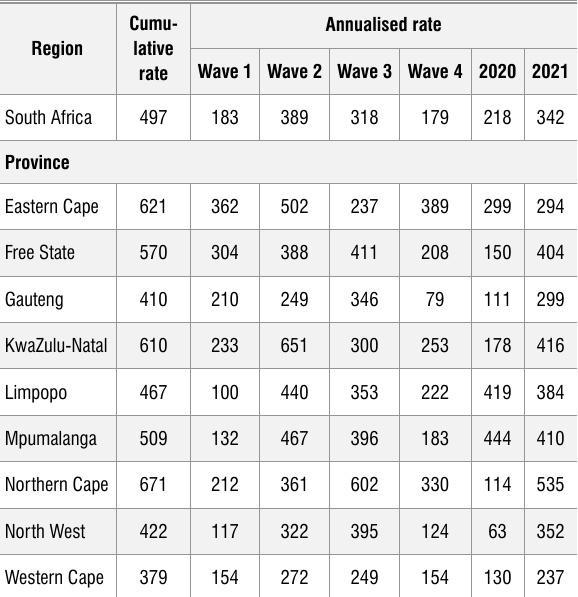
Figure 4: P-score of excess deaths in South Africa by week and age group, 29 December 2019 – 5 February 2022. Figure 5 shows age-specific annualised excess death rates per 1000 population (a) for the four waves (male and female individuals combined) and (b) for male and female individuals over all four waves